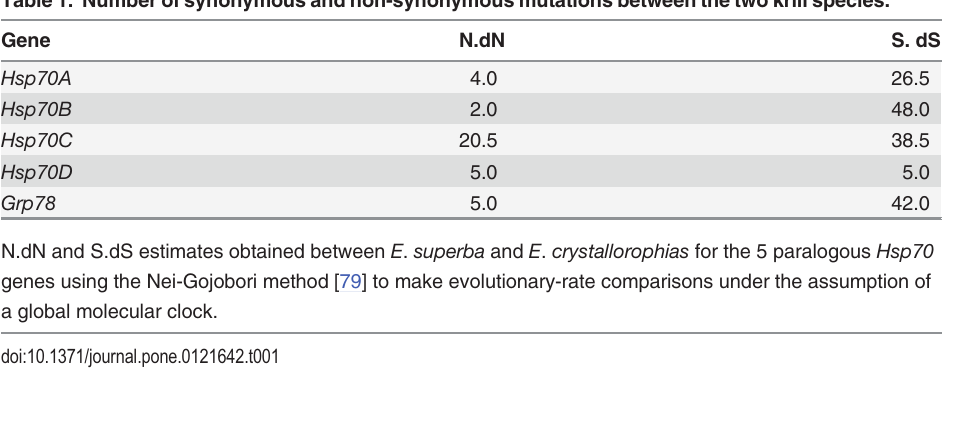
Table 1. Number of synonymous and non-synonymous mutations between the two krill species. Gene